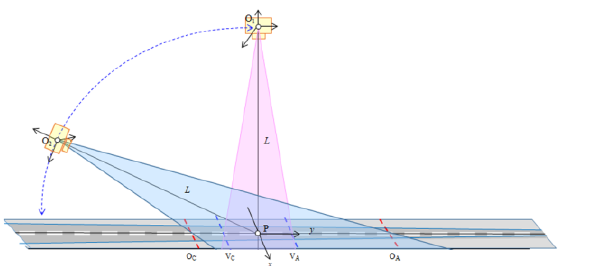
Figure 3 . Oblique image and vertical